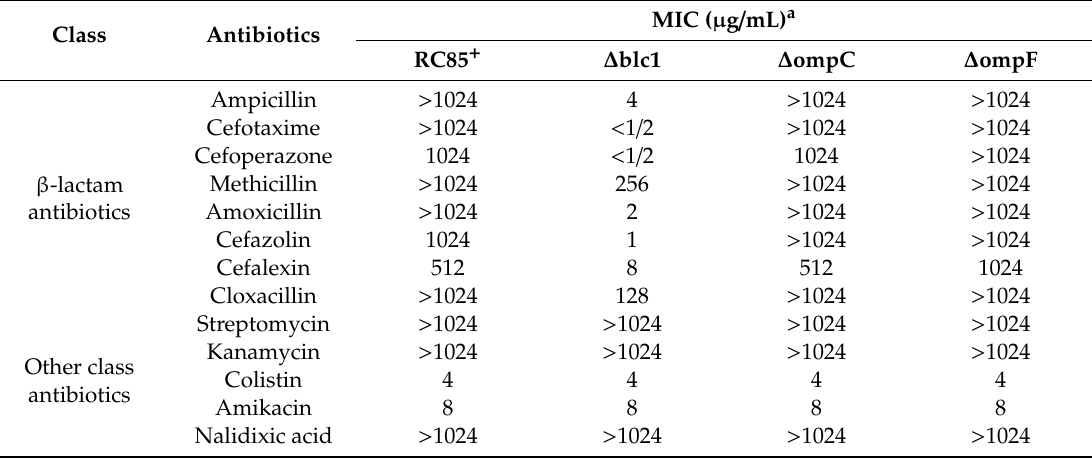
Figure 2. Growth curves of RC85 + and isogenic mutant strains of RC85 + (Δblc1, ΔompC, and ΔompF). The RC85 + and mutant strains were cultured on LB medium, and the growth of each strain was investigated by measuring absorbance at 600 nm. Data are presented as means and SEMs of three independent experiments. Table 1. The MIC of β-lactam antibiotics and other class antibiotics against the multidrug-resistant Escherichia coli RC85 + and isogenic mutant strains of RC85 + .